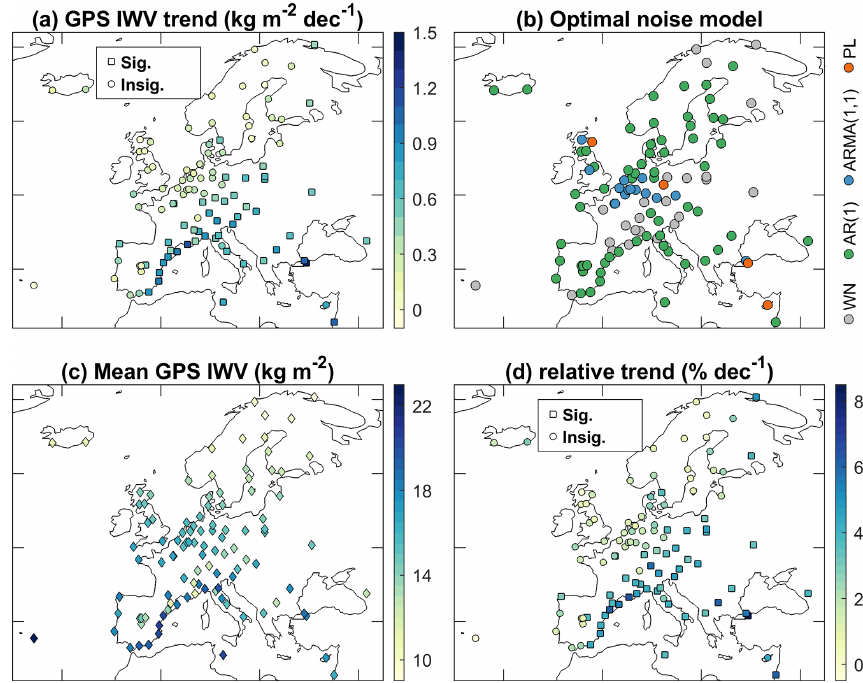
Figure 12. (a) Map of the absolute trends of the homogenised monthly GPS IWV anomaly time series. The squares and circles indicate the trend estimates being significant and insignificant at 95% confidence level, respectively. The trend uncertainties are estimated based on optimal noise models (b) . The relative trends (d) are calculated as the absolute trends (a) divided by the associated average IWV (c) .